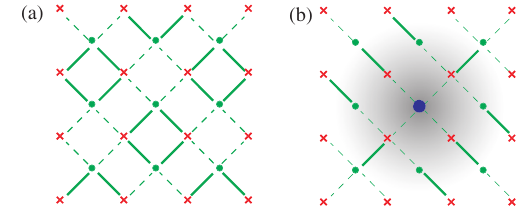
FIG. 11. (a) Dimerized model of a massive Dirac fermion. (b) Vortex of dimerizations Δ ¼ Δ 1 þ i Δ 2 that leaves behind a massless localized chiral Dirac channel (blue